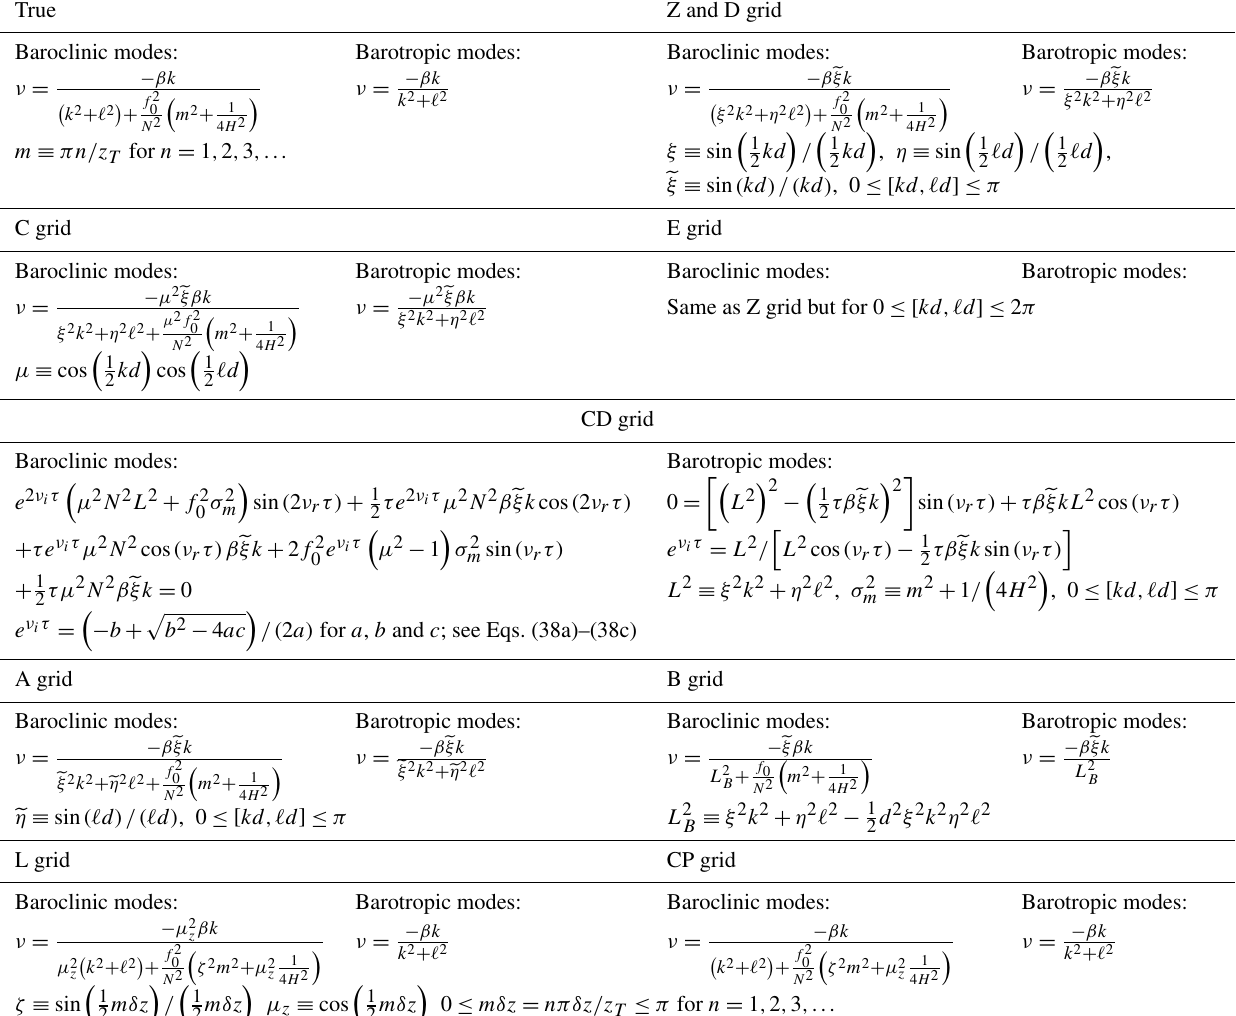
Table 1. A summary of the continuous and discrete dispersion relations with various horizontal and vertical grids. True Z and D